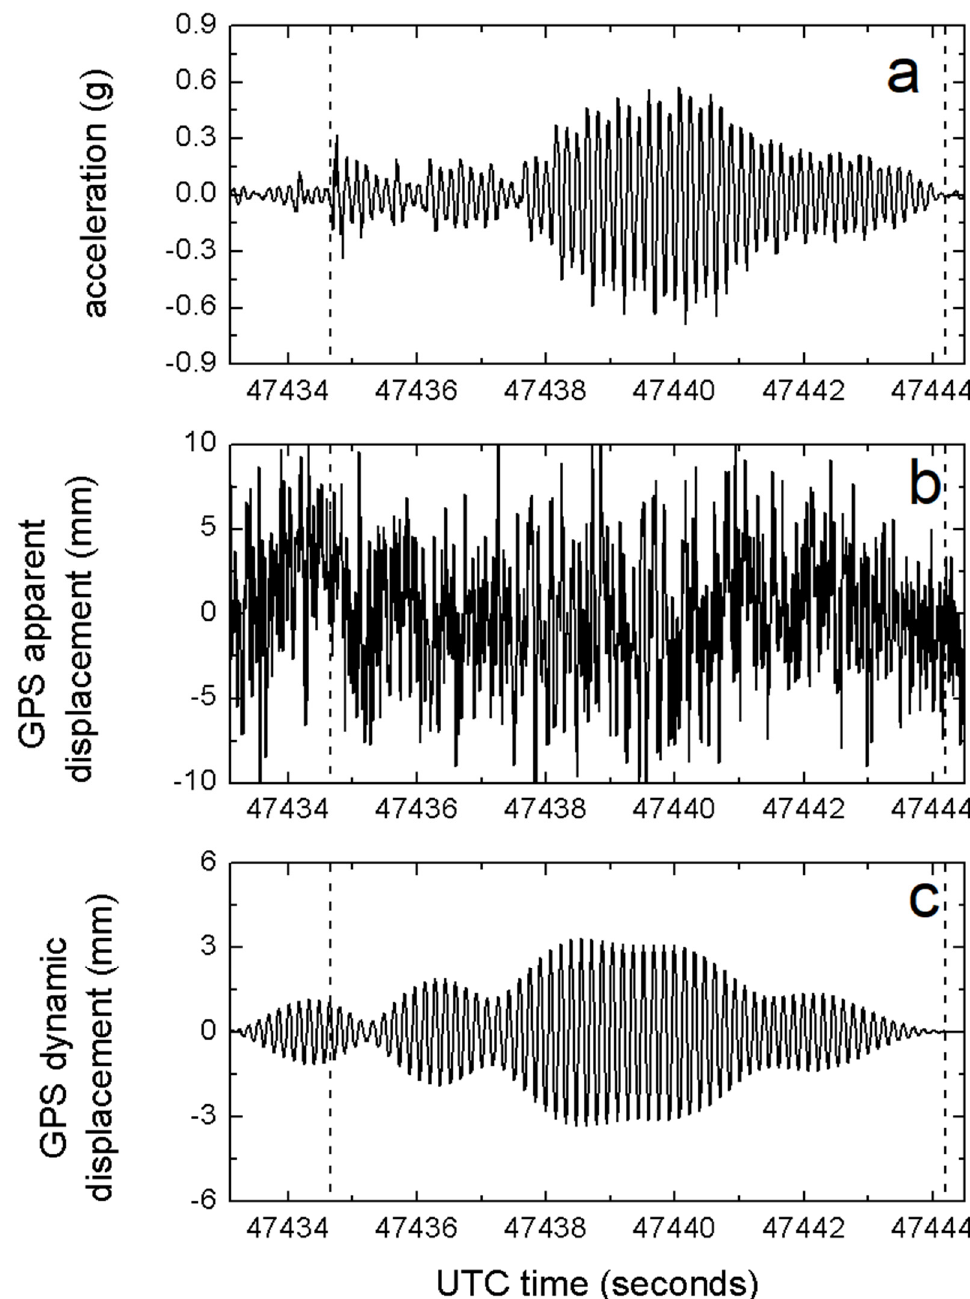
Figure 3. An example of denoising time series of GNSS-derived deflections of stiff bridges, in which the useful, high-frequency signal is masked by long-period noise. ( a ) Acceleration signal of the excitation of a certain bridge, stiff in the vertical axis. ( b ) the corresponding 100 Hz GNSS signal is covered by noise. ( c ) Band-pass filtering using structural constraints permits to reconstruct dynamic displacement. For details and analysis of a similar bridge excitation event, see [15].